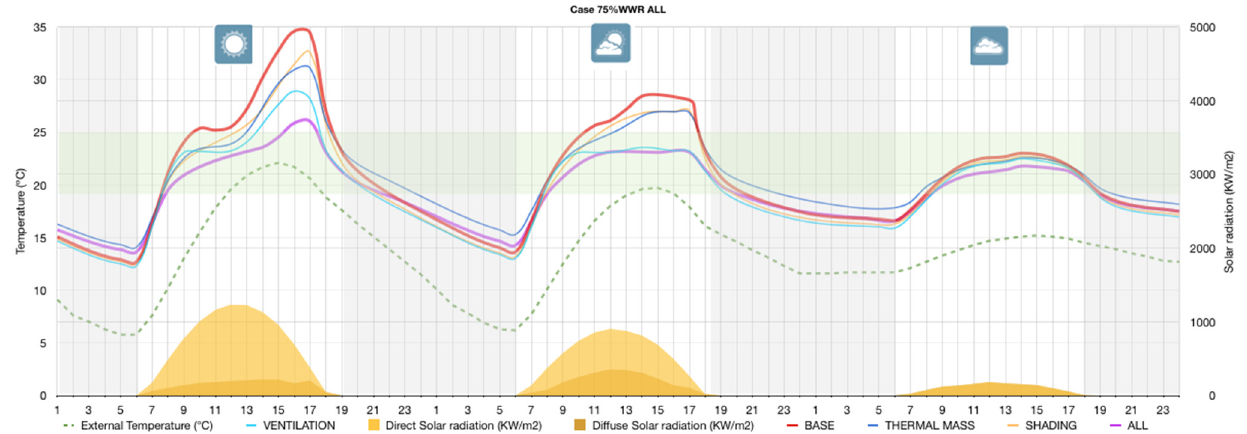
Figure 17. Thermal simulation for the scenario of 75% WWR and four sides exposed to the